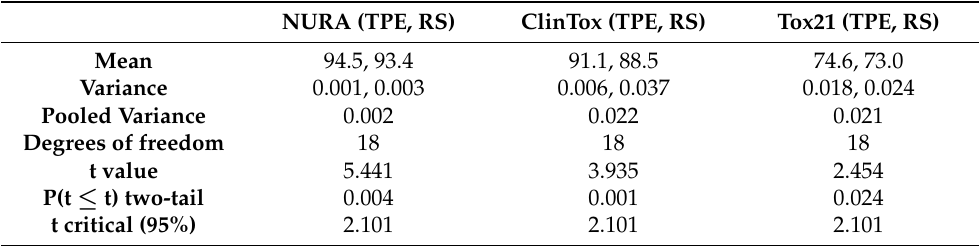
Table A3. Two-tailed t-test with a hypothesized zero mean difference for the three datasets consider- ing the best result among 10 replicas between tree-structured Parzen estimator (TPE) and random search (RS) on 3-fold cross validation. Variances were assumed